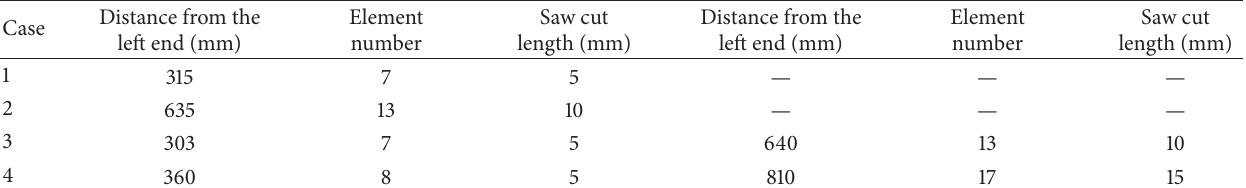
Table 6: Damage cases introduced to the beam.